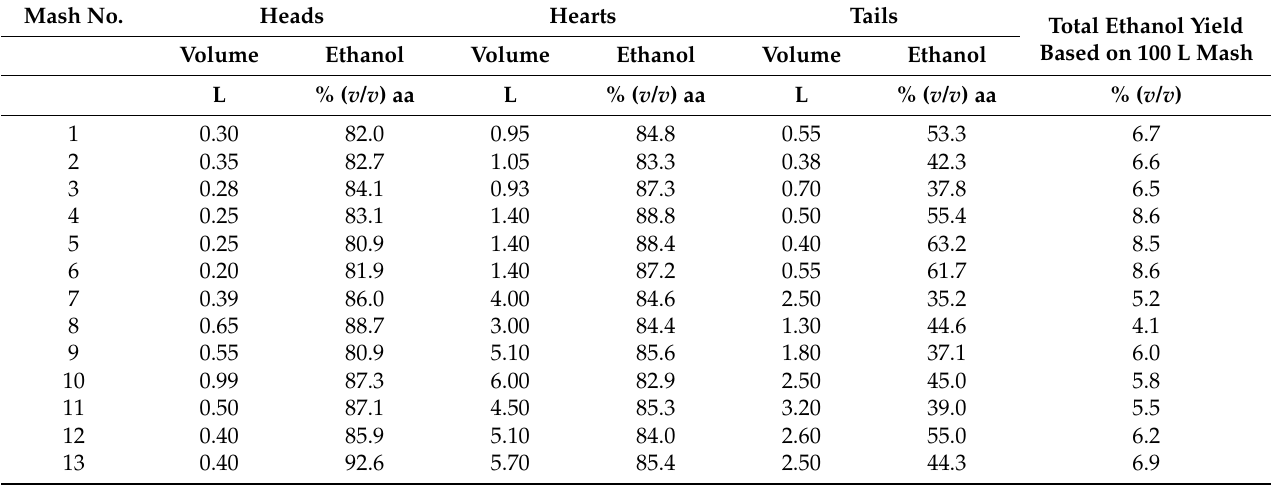
Table 2. Ethanol yields of heads, hearts and tails fractions. Ethanol concentrations determined in triplicates. Standard deviation ≤ 0.01. Mash